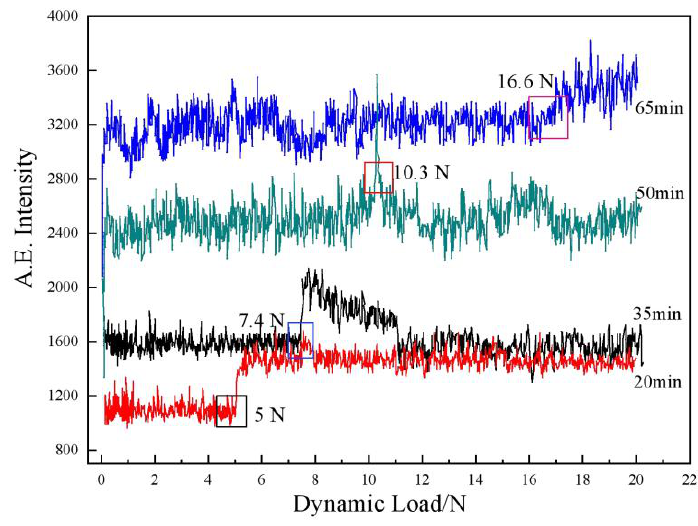
Figure 4. A.E curves of the coatings during the scratch test.